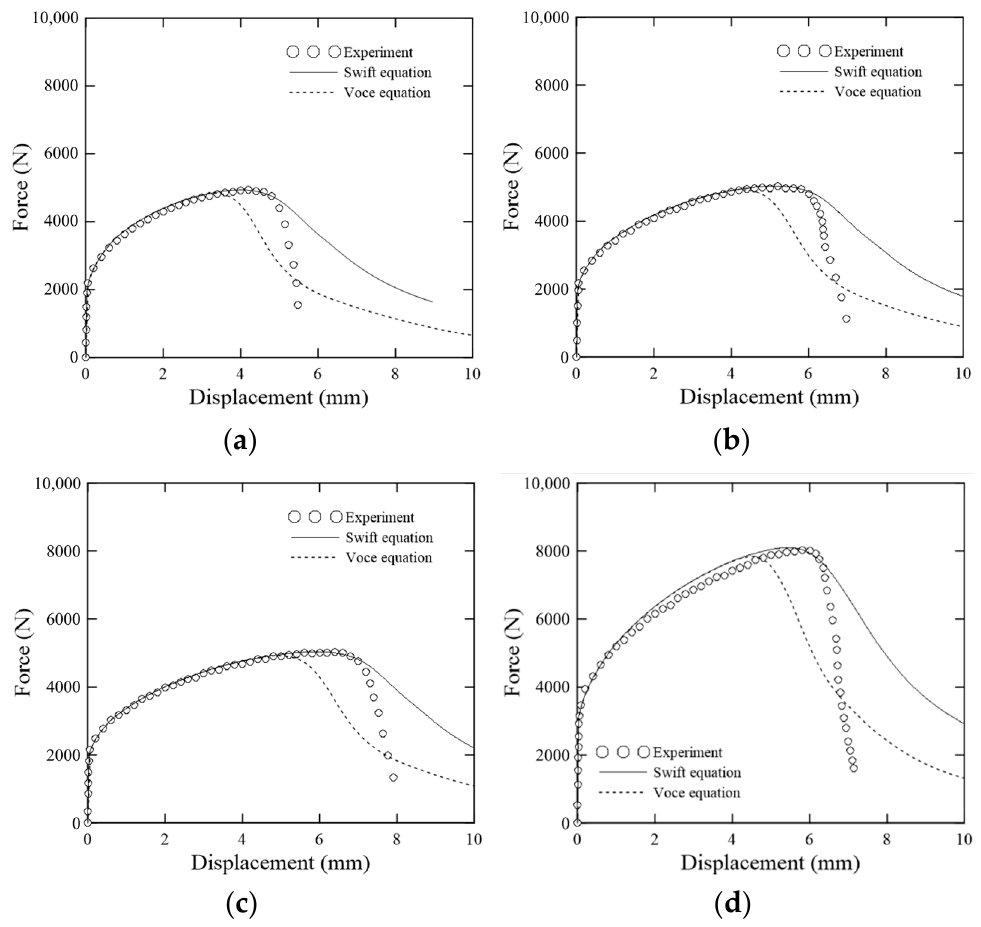
13 of 21 Figure 6. Flow stress of 304L stainless steel. Experimental results with engineering stress-strain re- lation are valid until the onset of the diffuse neck. In the domain of diffuse neck, the true stress is estimated through Swift equation and Voce equation. Table 2. Material parameters of 304L stainless steel. In this study, 304L stainless steel did not show a yield plateau, so the yield plateau was set to zero. Swift equation part